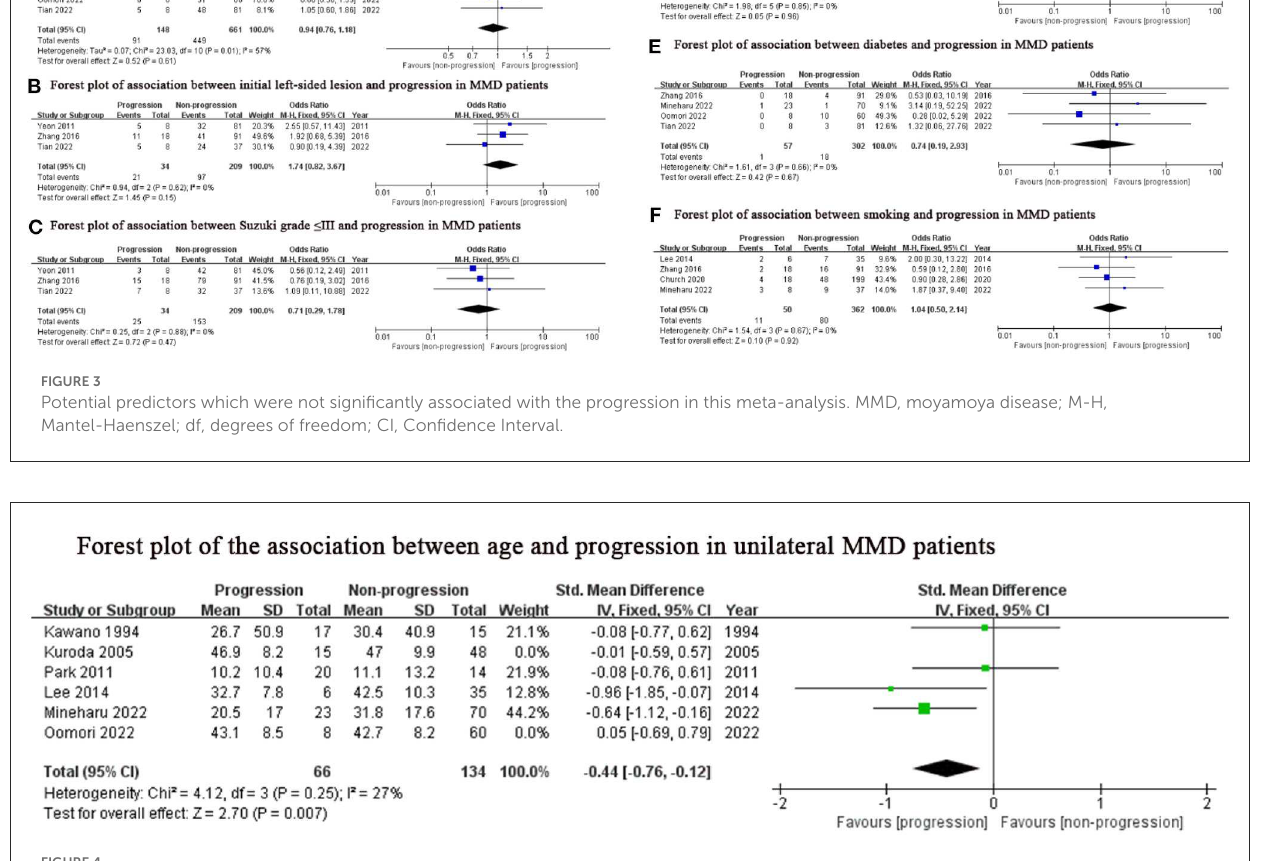
FIGURE4 Positive predictor for progression in unilateral MMD patients. MMD, moyamoya disease; SD, standard deviation; IV, Inverse variance; M-H, Mantel-Haenszel; df, degrees of freedom; CI, Confidence Interval; Std. Mean Difference, standardized mean